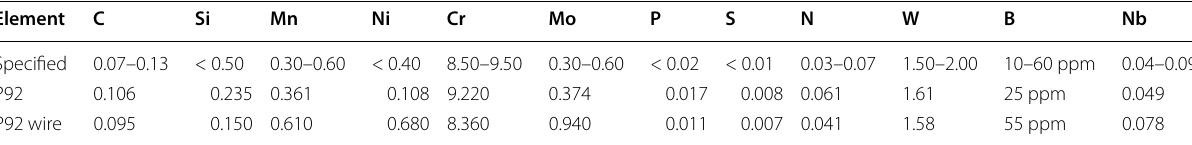
Table 1 Chemical composition of P92 steel and the welding consumable (wt. %) Element C